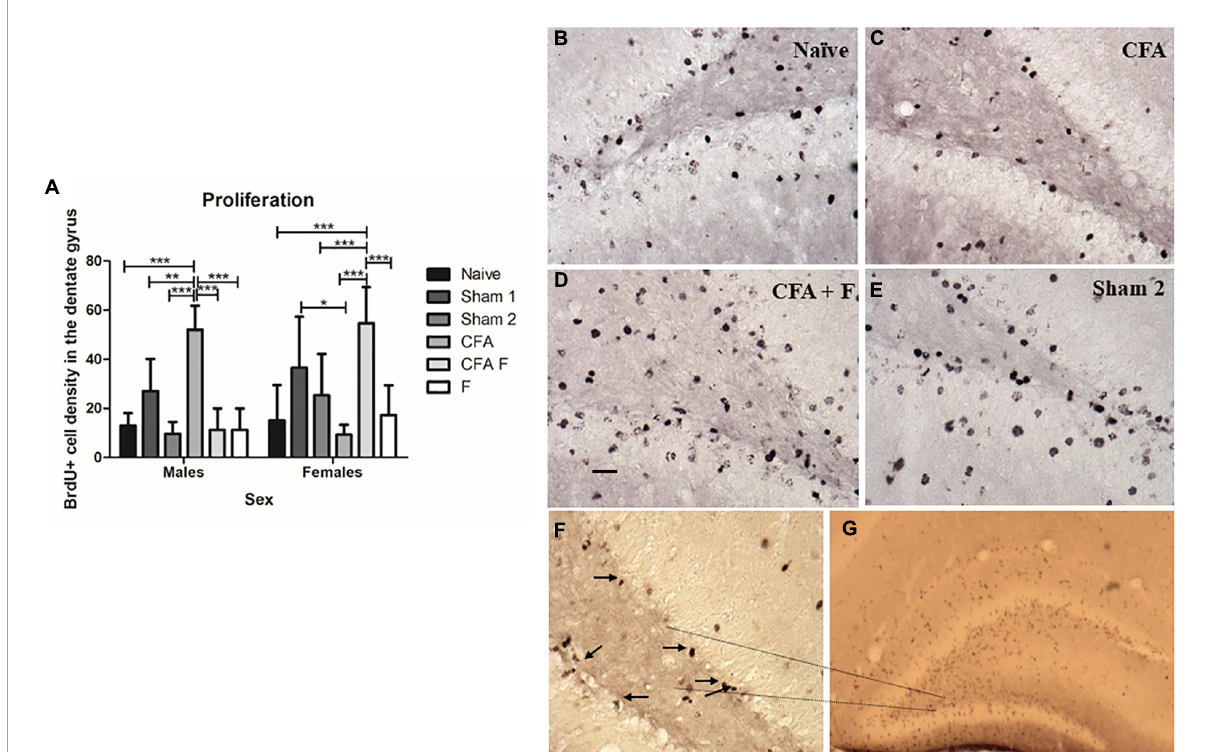
FIGURE3 Cell proliferation in the dentate gyrus on P10. (A) There was an interaction between Group*Sex [ F ( 5 , 44 ) = 11.963, p = 0.00]. Among females, the CFA + F group showed the highest number of BrdU-labeled cells in the dentate gyrus, whereas the CFA group showed the lowest number of BrdU-labeled cells. The CFA group demonstrated a decreased number of BrdU-labeled cells when compared to Sham 1 ( p = 0.02) and CFA + F ( p = 0.00) groups. The CFA + F group showed higher number of BrdU-labeled cells when compared to Naïve ( p = 0.00), Sham 2 ( p = 0.03), CFA ( p = 0.00) and F ( p = 0.00). Oppositely, among males, the CFA group demonstrated the highest number of BrdU-labeled cells in the dentate gyrus, when compared to Naïve ( p = 0.00), Sham 1 ( p = 0.01), Sham 2 ( p = 0.00), CFA + F ( p = 0.00) and F ( p = 0.00). (B–E) examples of BrdU-labeled cells in the dentate gyrus. (F) Subgranular zone of dentate gyrus, 40 × magnification, the arrows demonstrate the BrdU-labeled cells. (G) BrdU-labeled cells in the dentate gyrus, 4 × magnification. Scale bar: 25 µ m. * p < 0.05; ** p < 0.01; *** p <